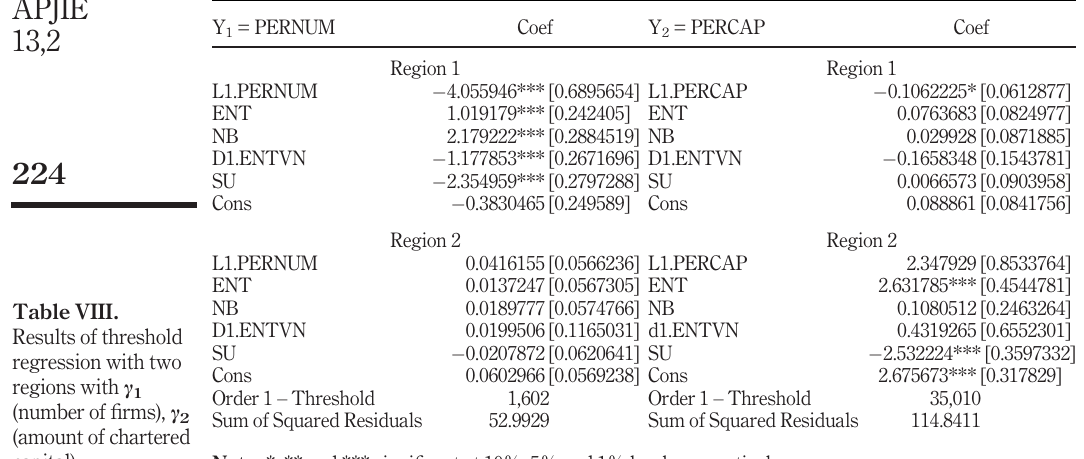
Table VIII. Results of threshold regression with two regions with c